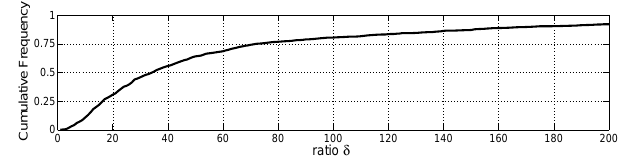
Fig. 9. Cumulative frequency of ratio δ for the C0 reference ensem-